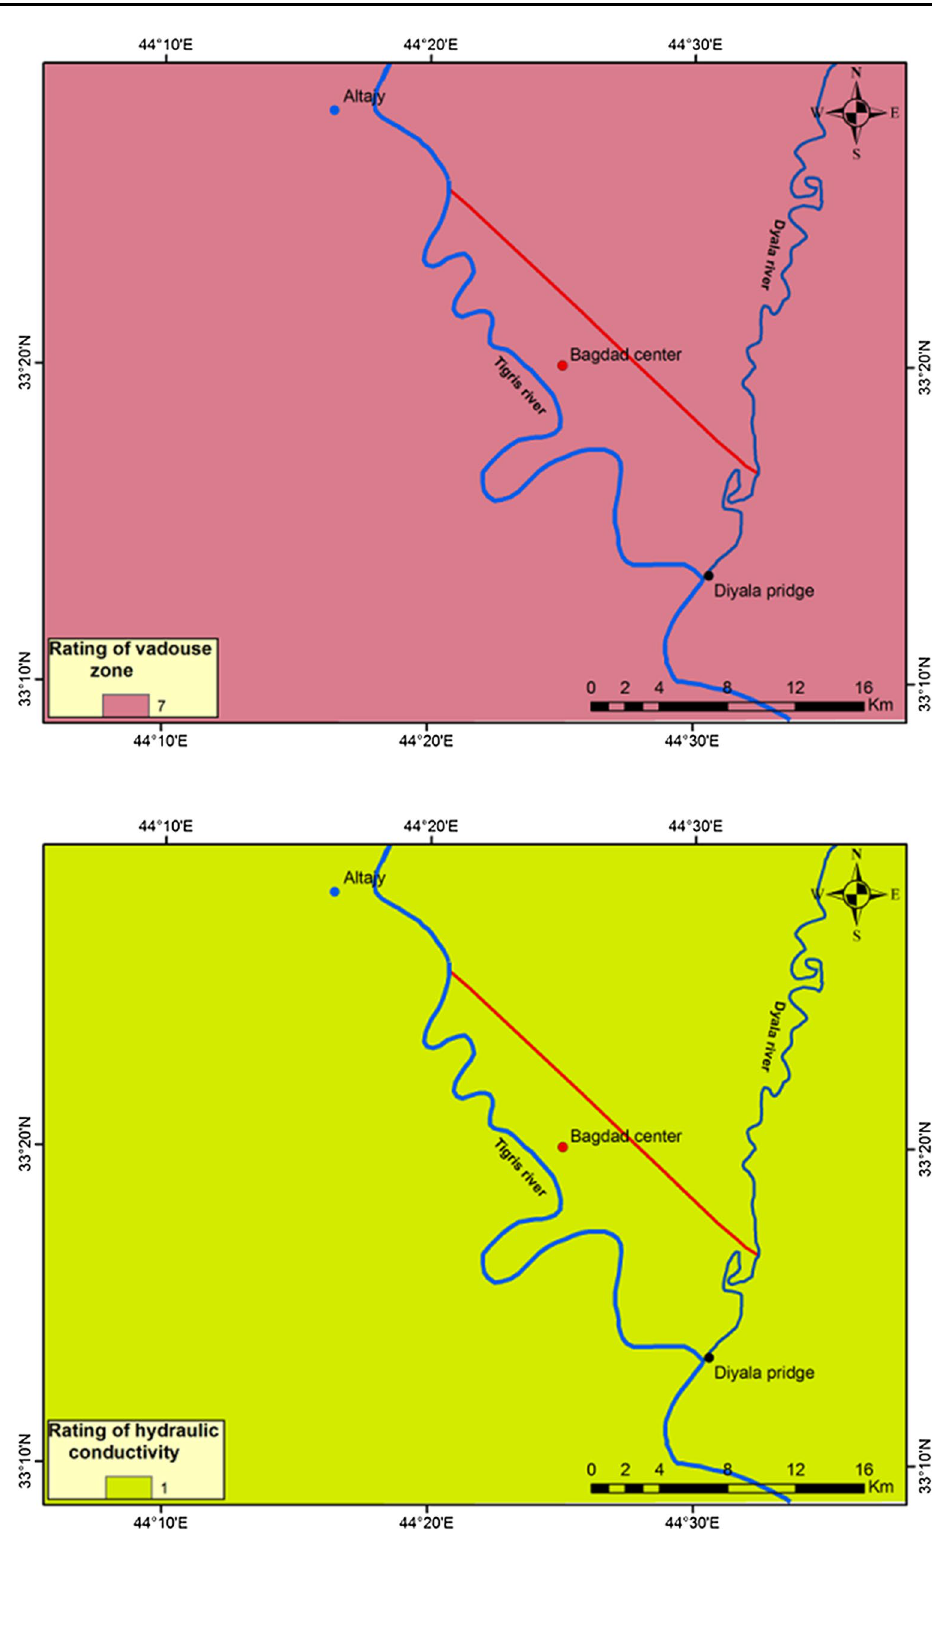
Fig. 11 Rating of vadose zone map of the study area